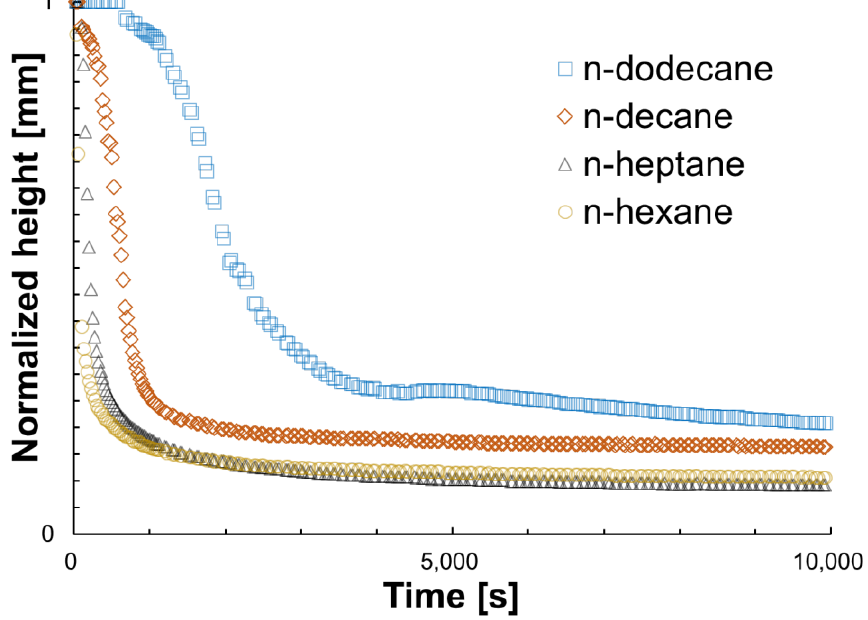
Figure 1. Normalized height as a function of time for the n -alkanes used in this work. The shape of the curves matches the shape of the % ∆ BS signals in the region where % ∆ T is below 0.2.